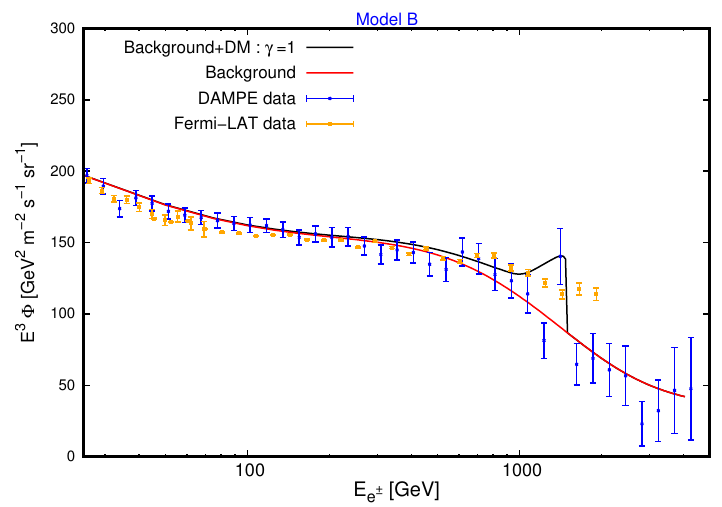
Figure 7 . The electron and positron (cid:13)ux produced in a nearby DM subhalo is shown. A dark matter candidate with the mass about 1 : 5 TeV plus the background explains the peak observed by the DAMPE. The result is compared with the Fermi-LAT data for electron-positron (cid:13)ux. The relic density constraint is applied here, such that with the choices m s = 800 GeV and v s = 100 GeV it is obtained for the gauge coupling g 0 (cid:24) 0 : 57 and for the gauge boson mass m Z 0 (cid:24) 40